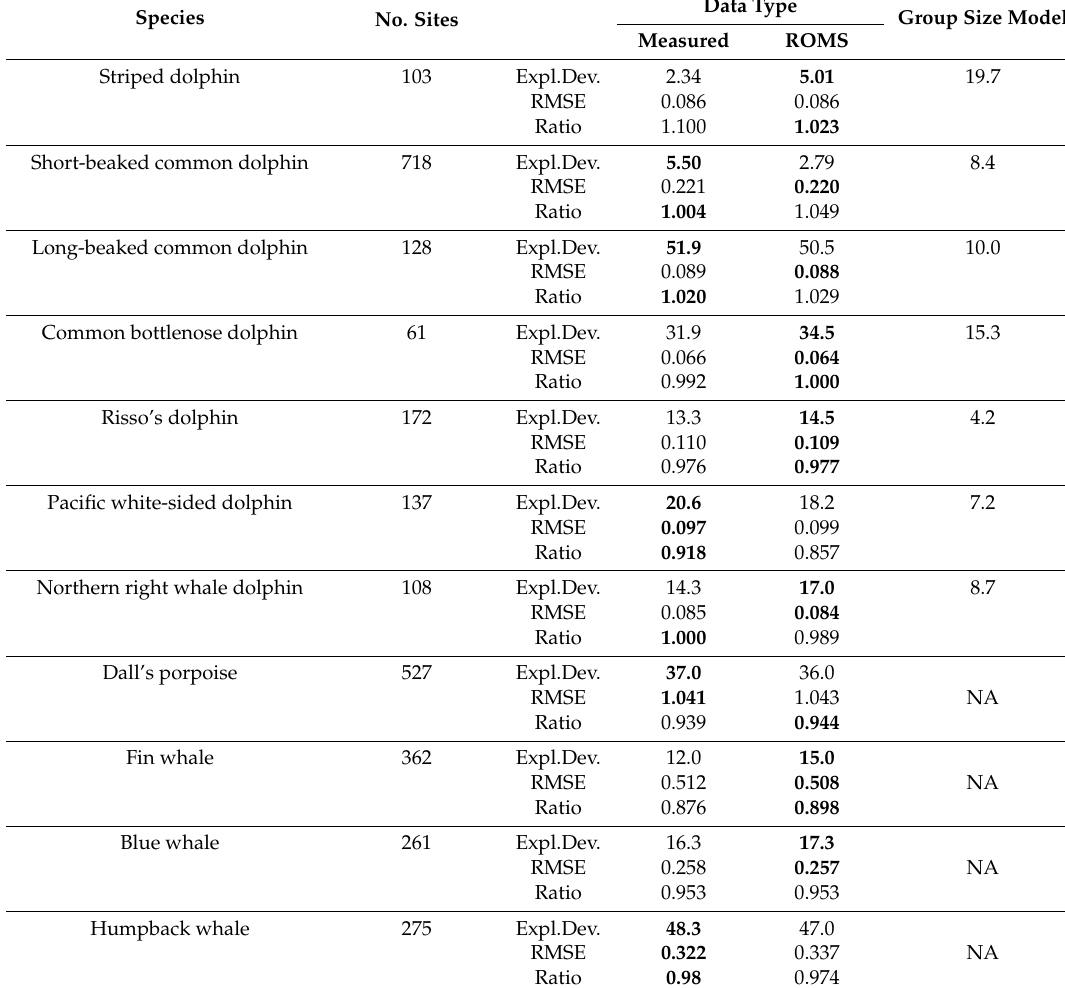
Table 2. Percentage of explained deviance (Expl. Dev.) and root mean squared error (RMSE) for the final encounter rate (delphinids) or single response (Dall’s porpoise and large whales) GAMs built with either measured data or ROMS output. Percentage of explained deviance is also shown for the delphinid group size models (same spatial model used for both data types). The number of sightings (No. sites) reflects the total available for model development. Ratios of line-transect over model-predicted density estimates (Ratio) are for the total study area as calculated for each segment and summed. Values indicating better performance are shown in bold